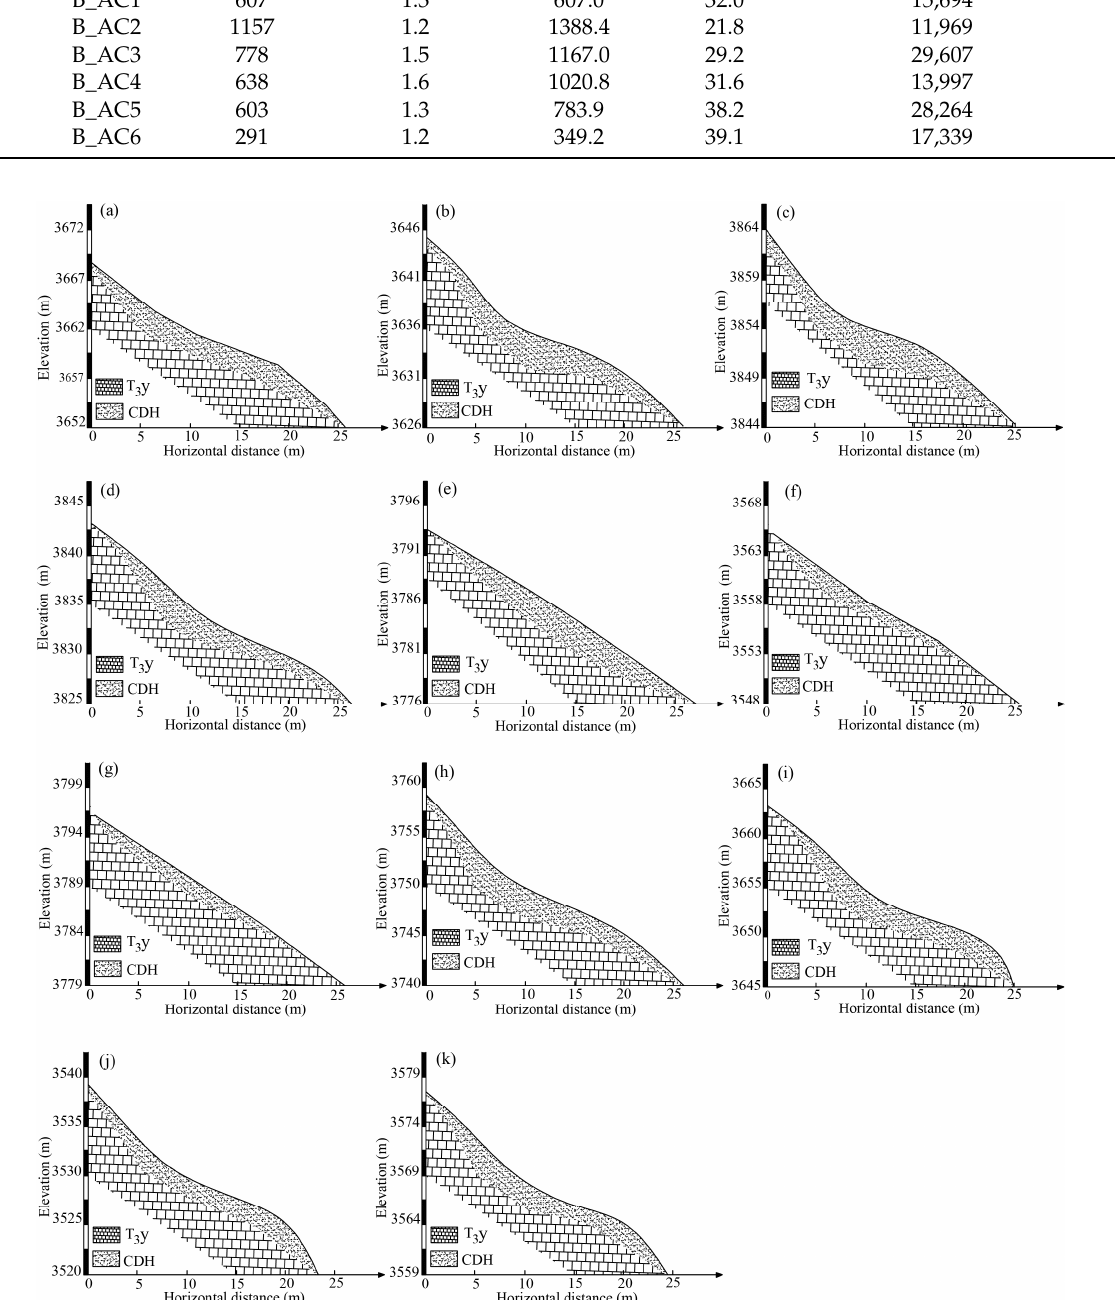
Figure 6. CDH profiles in the Catuo gully and the Dakang gully. ( a – e ) A_AC1–A_AC5 in the Catuo gully. ( f – k ) B_AC1–B_AC6 in the Dakang Table 2. Geometric parameters of the CDH of the Catuo gully and the Dakang gully.